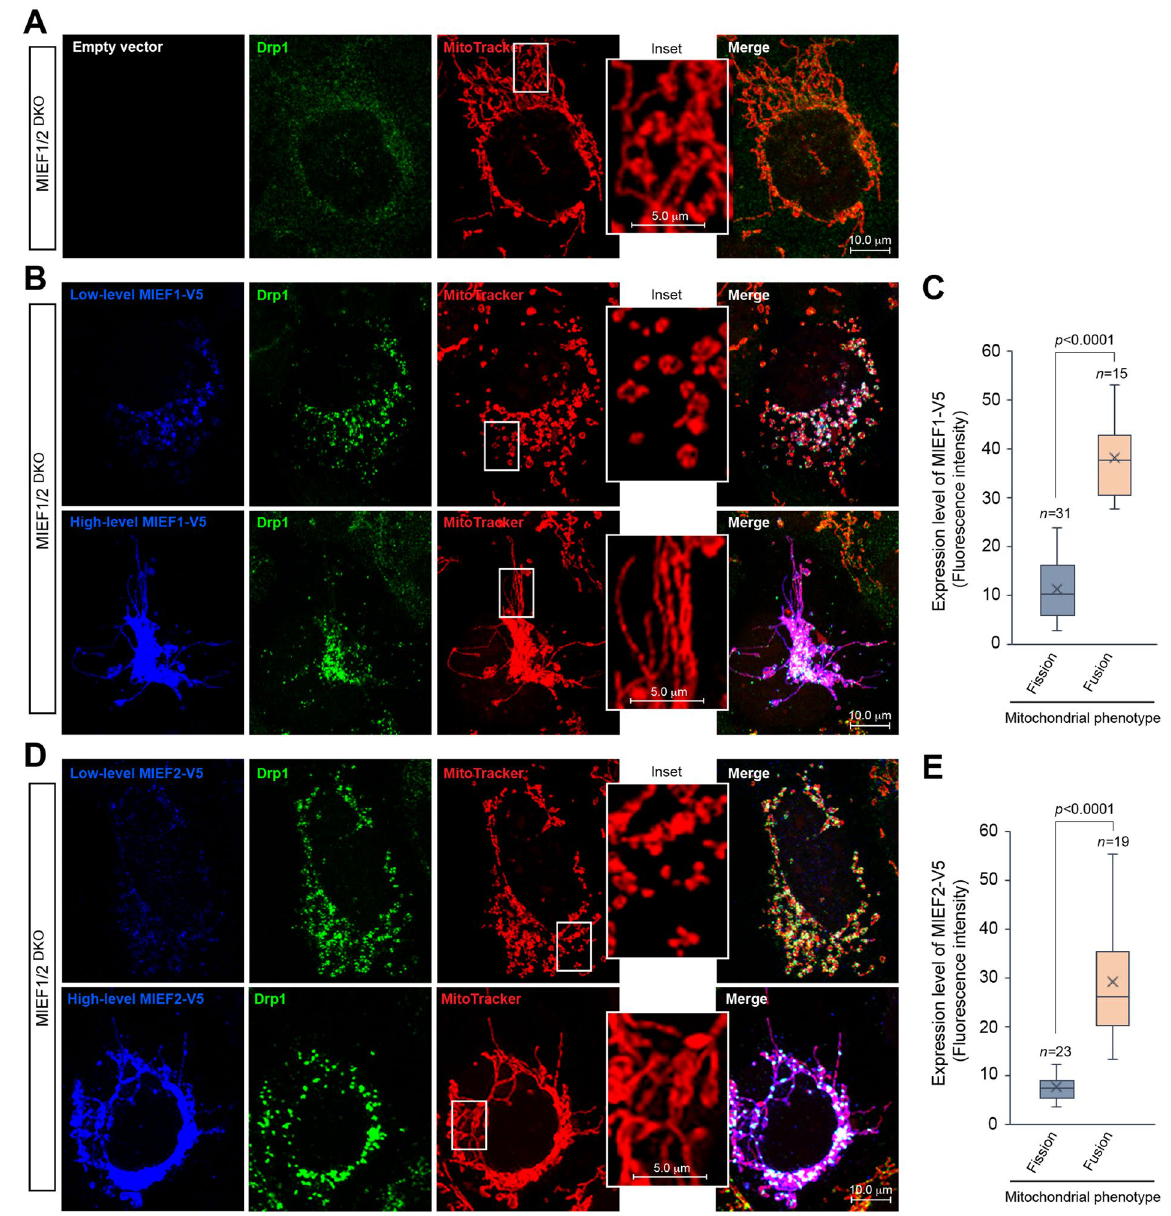
Figure 7. Different levels of MIEFs positively or negatively regulate mitochondrial fission. ( A ) Confocal images of mitochondrial morphology and Drp1 distribution in MIEF1/2 DKO 293T cells transfected with empty vector as control. ( B , D ) Confocal images of mitochondrial morphology and Drp1 distribution in MIEF1/2 DKO 293T cells transfected with MIEF1-V5 ( B ) or MIEF2-V5 ( D ) plasmid, stained with MitoTracker (red) followed by immunostaining with anti-Drp1 (green) and anti-V5 (blue) antibodies. Insets represent a magnified view of the respective boxed areas. ( C , E ) Box plots showing protein levels of MIEF1-V5 or MIEF2-V5 relative to the mitochondrial fission and fusion phenotypes. Expression levels of exogenous MIEF1-V5 ( C ) and MIEF2-V5 ( E ) in sets of cells as indicated showing either a mitochondrial fission or fusion phenotype were measured as immunofluorescence intensity using the Leica confocal microscopy software and shown by the box-plot analyses. The p -value represents the result from the Student’s t-test